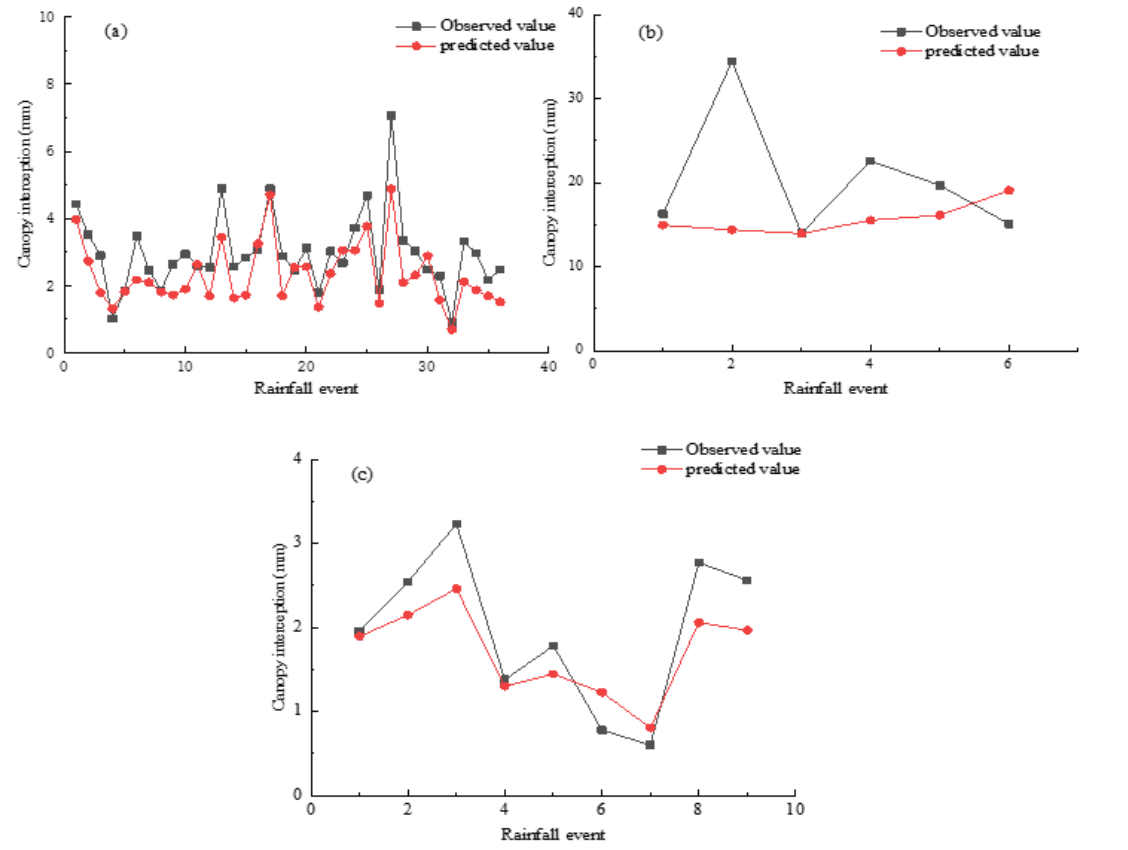
Figure 5. Comparison of individual observed and predicted canopy interception. ( a ): Rainfall pattern A; ( b ): rainfall pattern B; ( c ): rainfall pattern C.